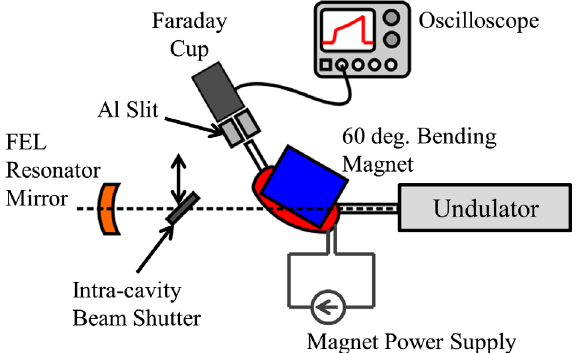
FIG. 1. Schematic drawing of the experimental setup for the extraction efficiency measurement. Only the downstream side of the undulator is depicted in this figure.